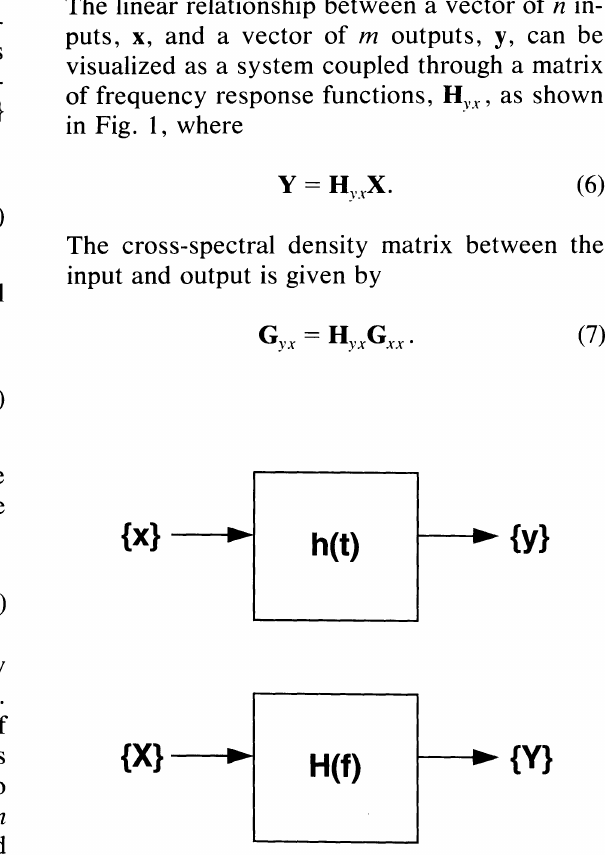
FIGURE 1 Multiple-inputlmultiple-output